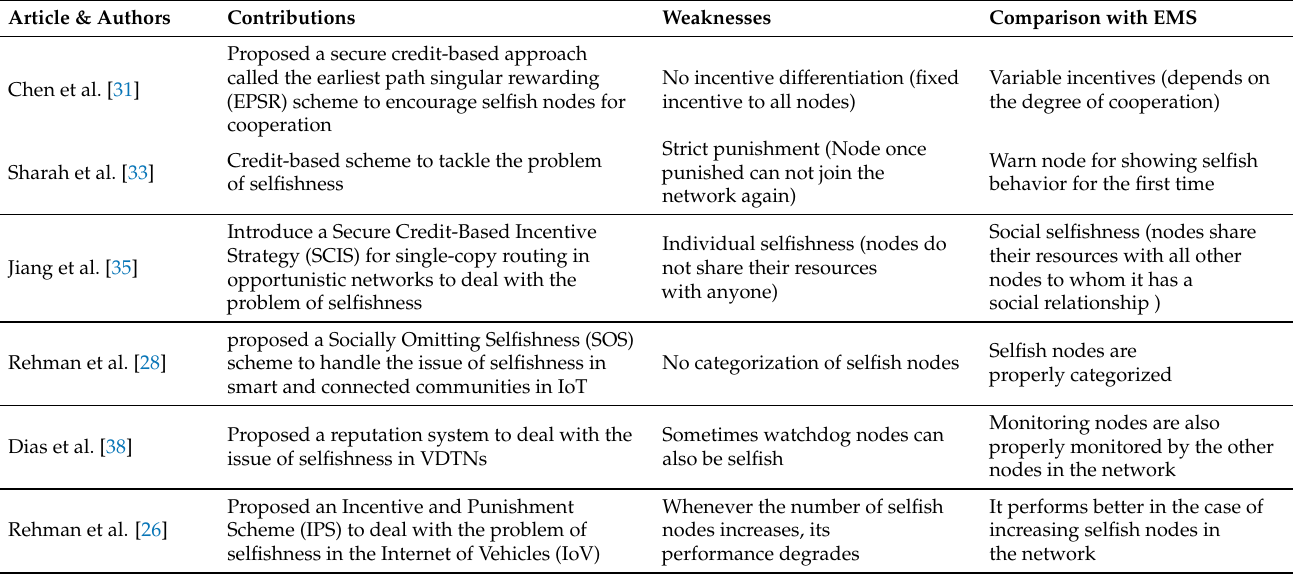
Table 4. Comparison of the proposed system with other schemes.